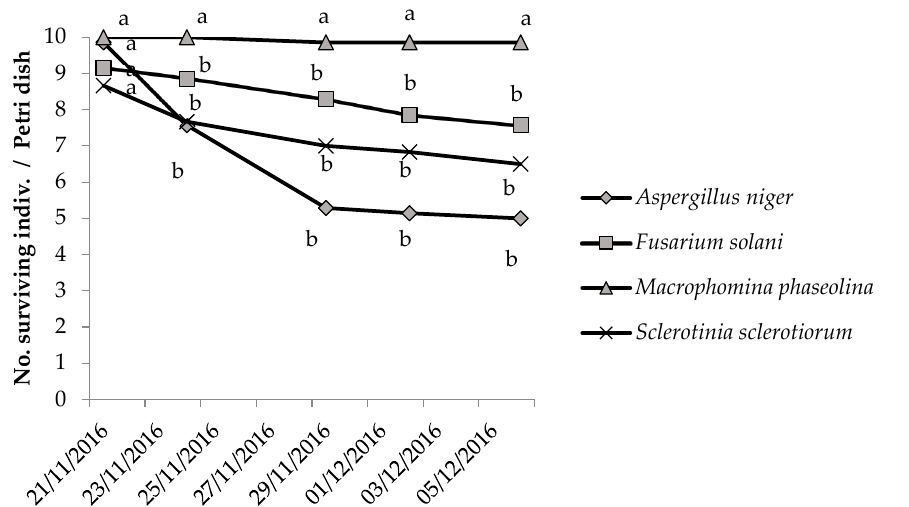
Figure 9. Number of surviving Porcellionides pruinosus individuals kept on different mycelial diets in Petri dishes. The initial number of individuals was 10 per Petri dish. Different letters for the same sampling date indicate significant differences (ANOVA, Tukey’s post hoc test).